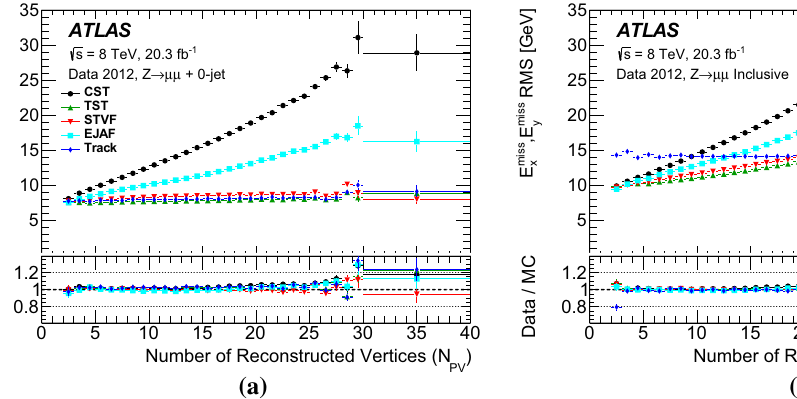
Fig. 7 The resolution obtained from the combined distribution of E miss x and E miss y for the CST, STVF, EJAF, TST, and Track E miss rithms as a function of N PV in a 0-jet and b inclusive Z → μμ events